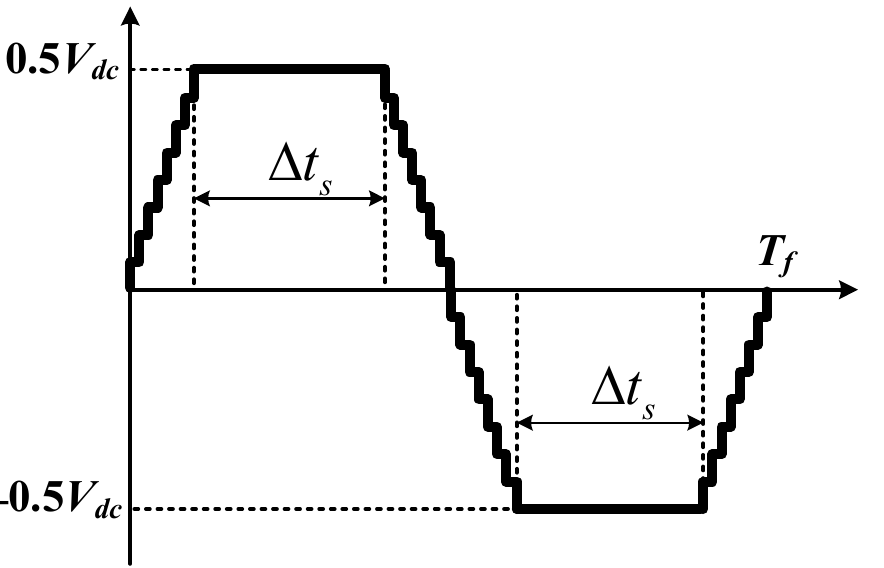
Figure 8. Trapezoidal waveform modulation of the proposed hybrid MMC. For simplification, the saturation rate λ of the trapezoidal waveform is defined as